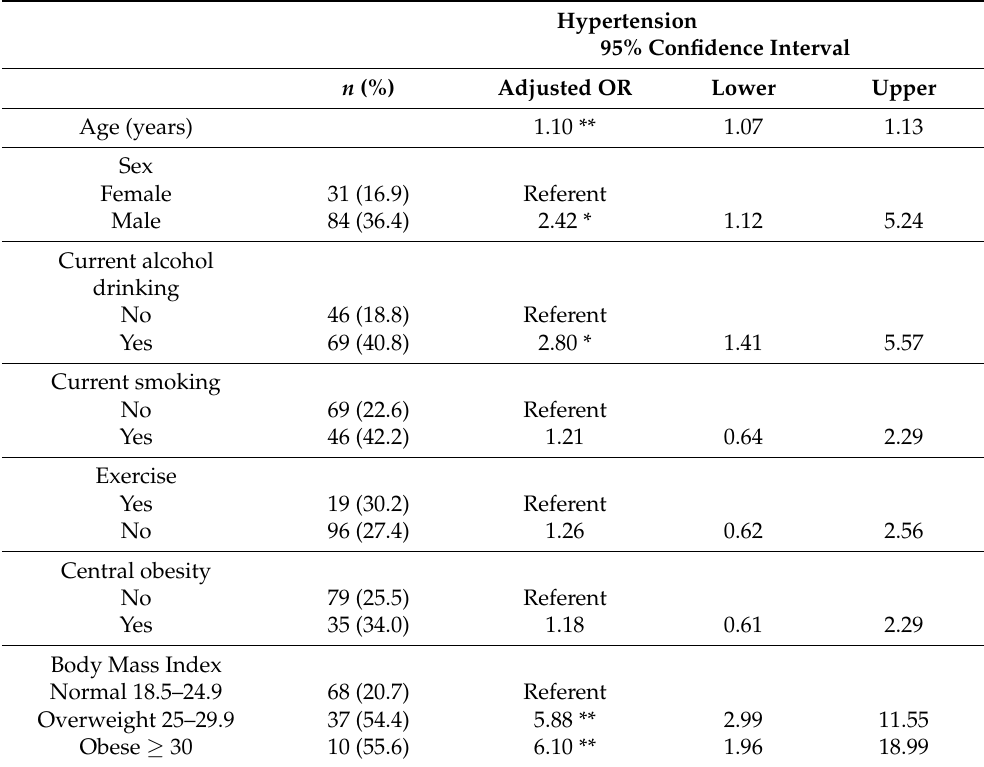
Table 2. Factors associated with hypertension among Myanmar migrant workers in